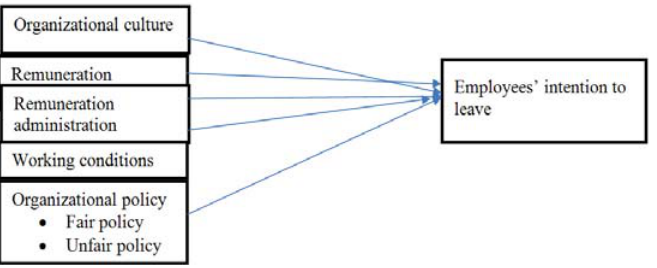
Fig. 1. Proposed model of the relationship between human resource practices (organizational culture, remuneration, working conditions and organizational policy and employees’ intention to leave)